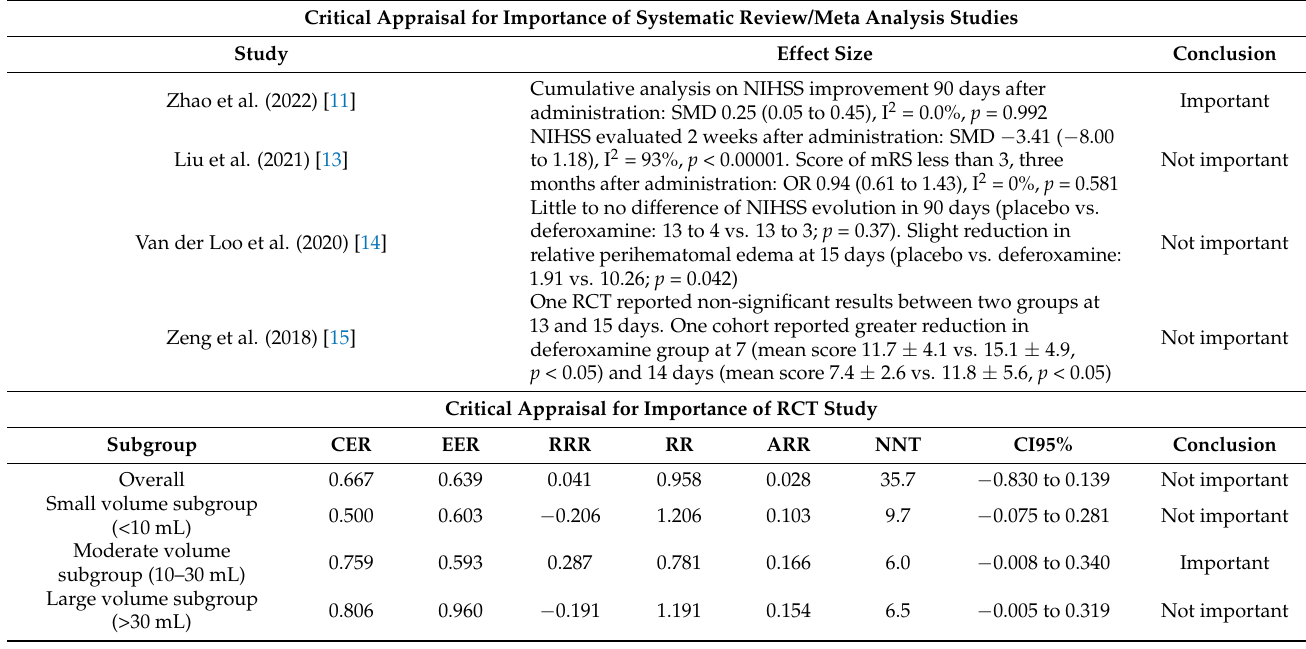
Table 3. Critical appraisal for importance of studies